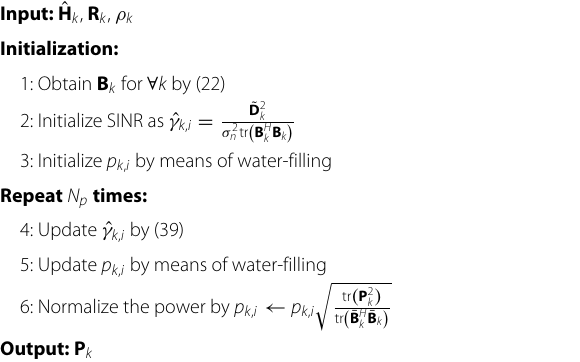
Table 1 Power allocation procedure Table 2 Main simulation